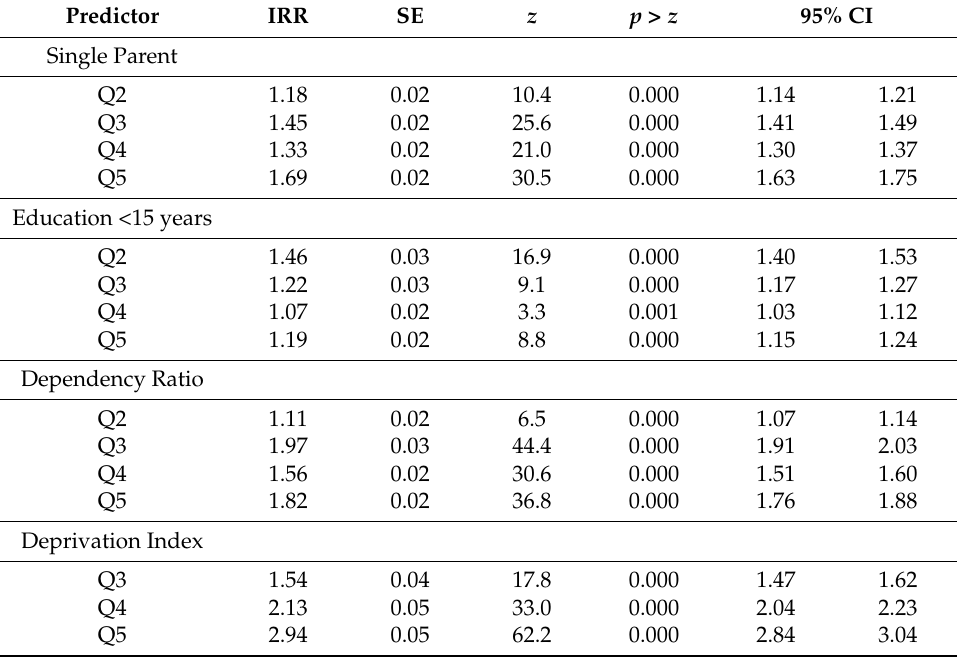
Table 2. Truncated Poisson regression model to predict Hospital Admission